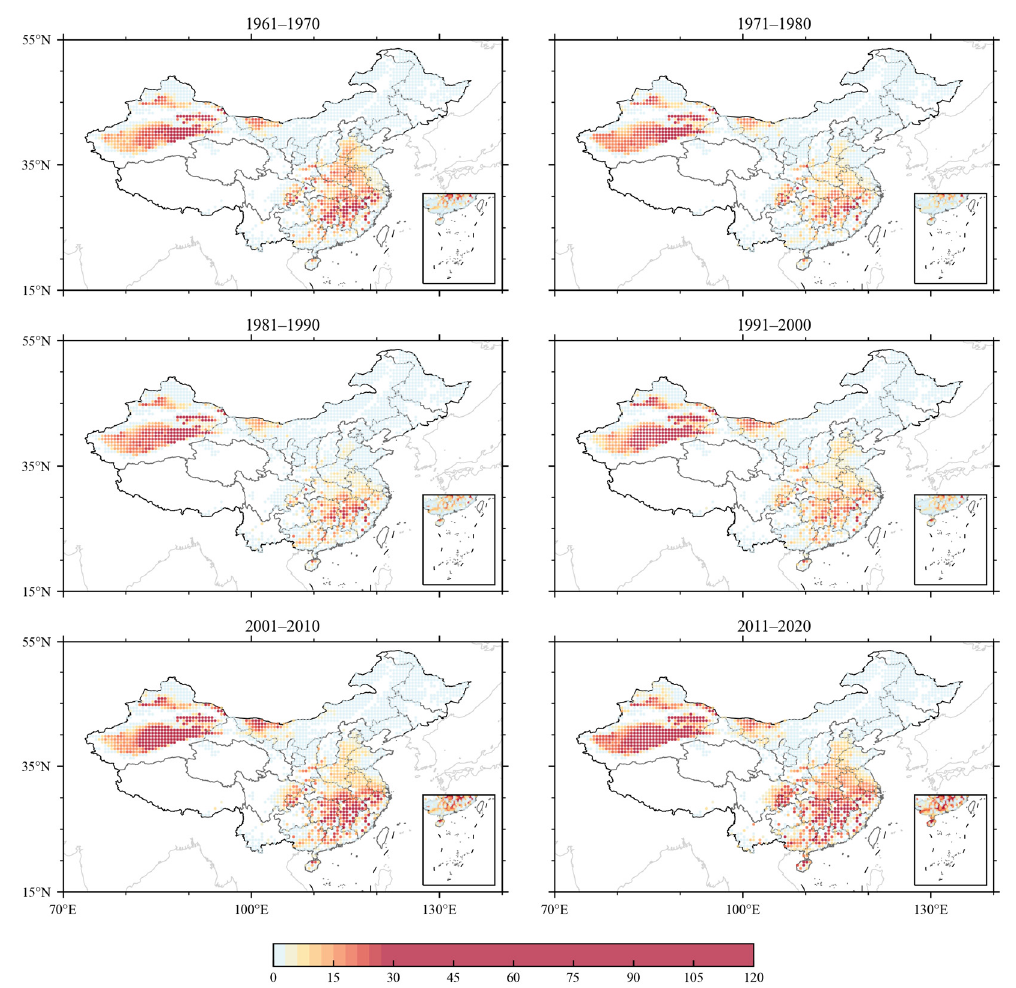
Figure 4. Distribution diagram of the average duration of heat waves in decadal period based on absolute method.